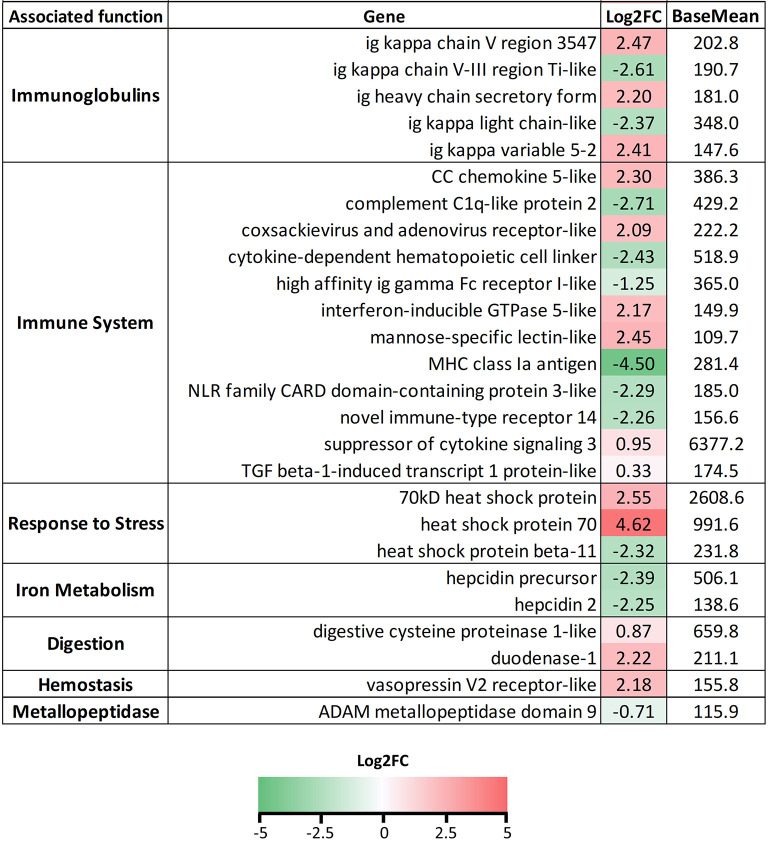
List of selected genes DE in liver samples of Ceratothoa-infected Dicentrarchus labrax. The genes were grouped in categories regarding their associated function. The numbers represent the Log2 fold change values and the color scale corresponds to −5-0-5 (green-white-red) Log2FC. BaseMean values represent the average of normalized counts divided by the size factor, taken over all samples.